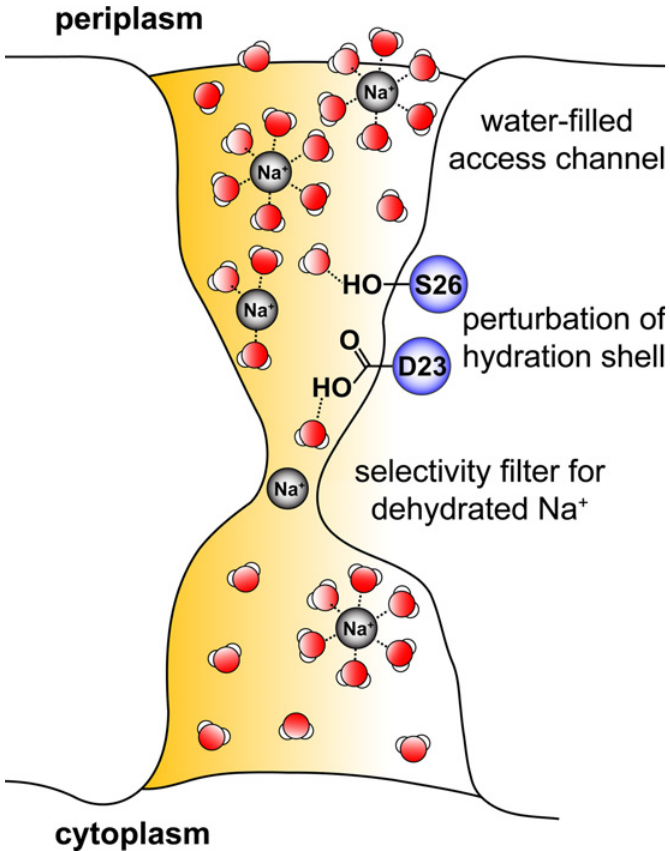
Fig 8. Na + flux through the flagellar PomA 4 PomB 2 complex by a channel-like mechanism. Na + enters the PomA 4 PomB 2 stator complex in its hydrated state from the periplasm via a water-filled access channel. The conserved amino acid residues S26 and D23 within the membrane-bound region of PomB interact with water molecules surrounding the central Na + , hereby perturbing its hydration shell. The sodium ion passes the narrow constriction site, or selectivity filter, in its dehydrated state. After passage through the filter, Na + is hydrated and released towards the cytoplasmic side of the stator. The downhill flux of Na + from the periplasm to the cytoplasm is driven by the electrochemical Na + gradient across the inner membrane.